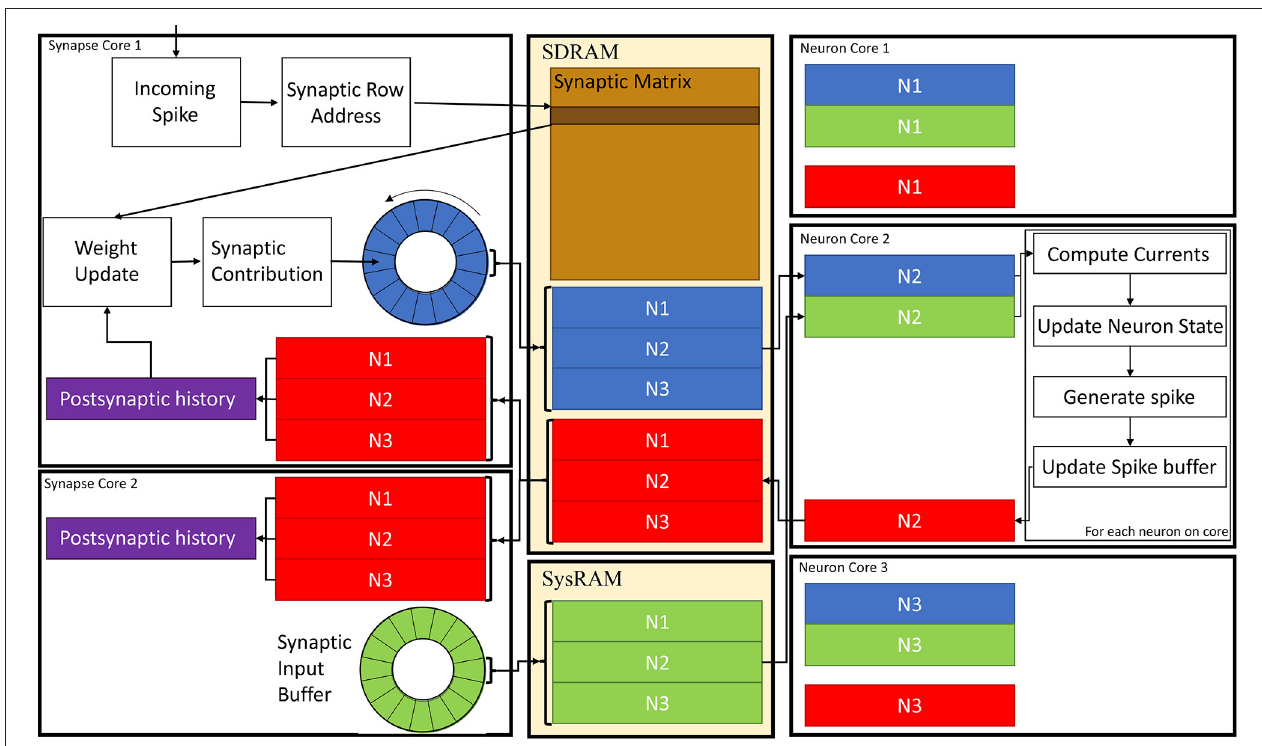
FIGURE 6 | Synapse and Neuron cores memory interaction for the Multi-target partitioning. 2 Synapse cores targeting 3 Neuron cores are shown with all the steps from spike reception to neural state update. Communication between cores belonging to the same ensemble happens via the two shared memories (SDRAM and SysRAM), through the represented data